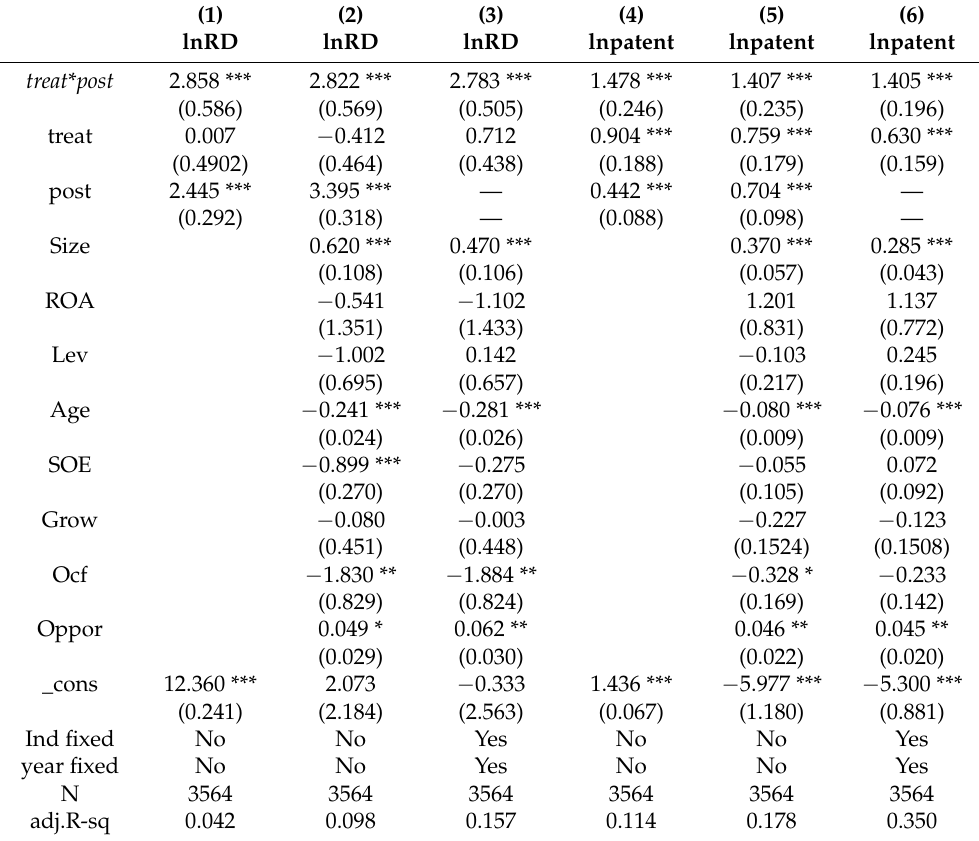
Table 3. Impact of the pilot ETS on enterprises’ technology